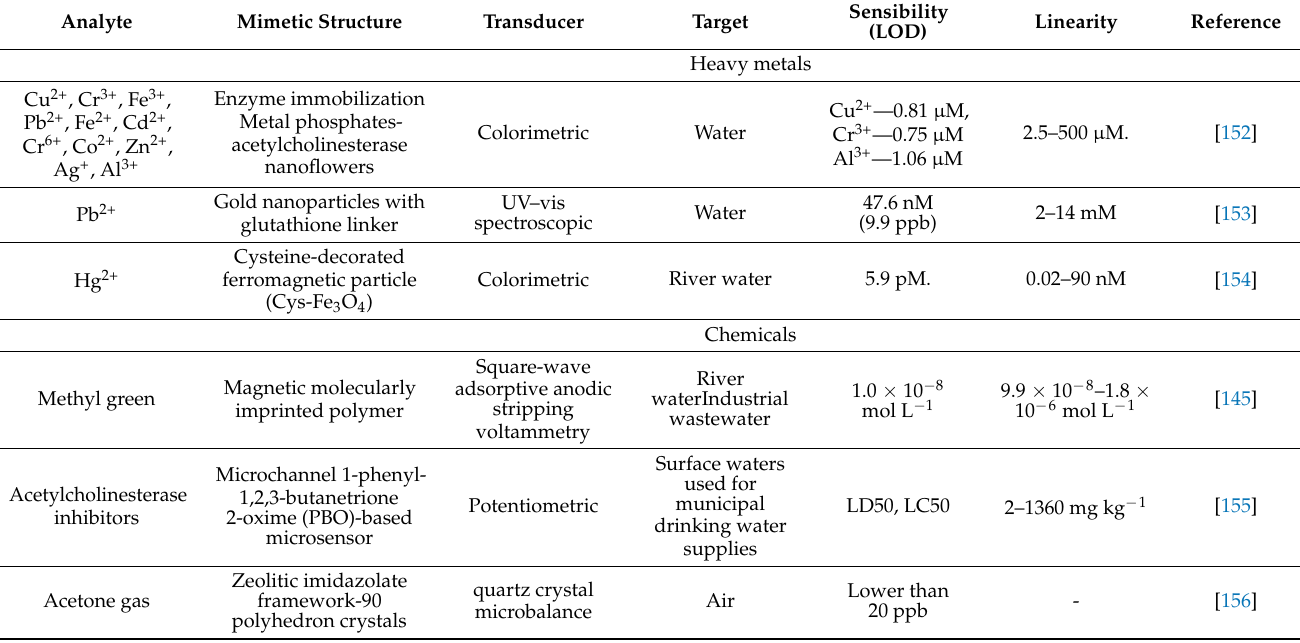
Table 7. Examples of biomimetic sensors used for environmental